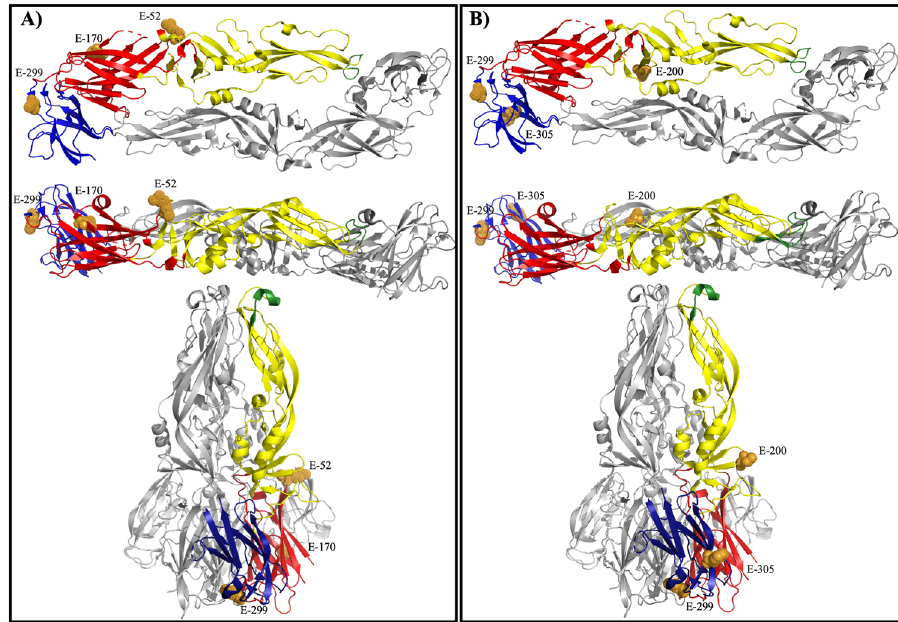
Fig. 4 Mapping residues important to mouse liver MRP and mouse brain MRP binding to YFV E protein. Residues important to the YFV interact with AG129 liver MRP in both Asibi and 17D backbones were mapped to the prefusion E protein structure and displayed from the top and side view as well as the post-fusion structure ( A ). Residues important to the YFV interact with AG129 brain MRP in both Asibi and 17D backbones were mapped to the prefusion E protein structure and displayed from the top and side view as well as the post-fusion structure ( B